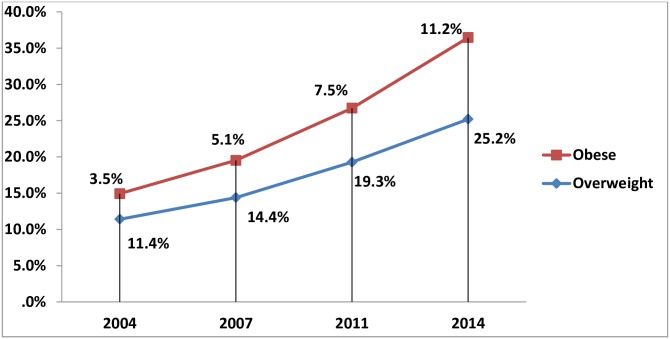
Trend of overweight and obesity 2004 to 2014.